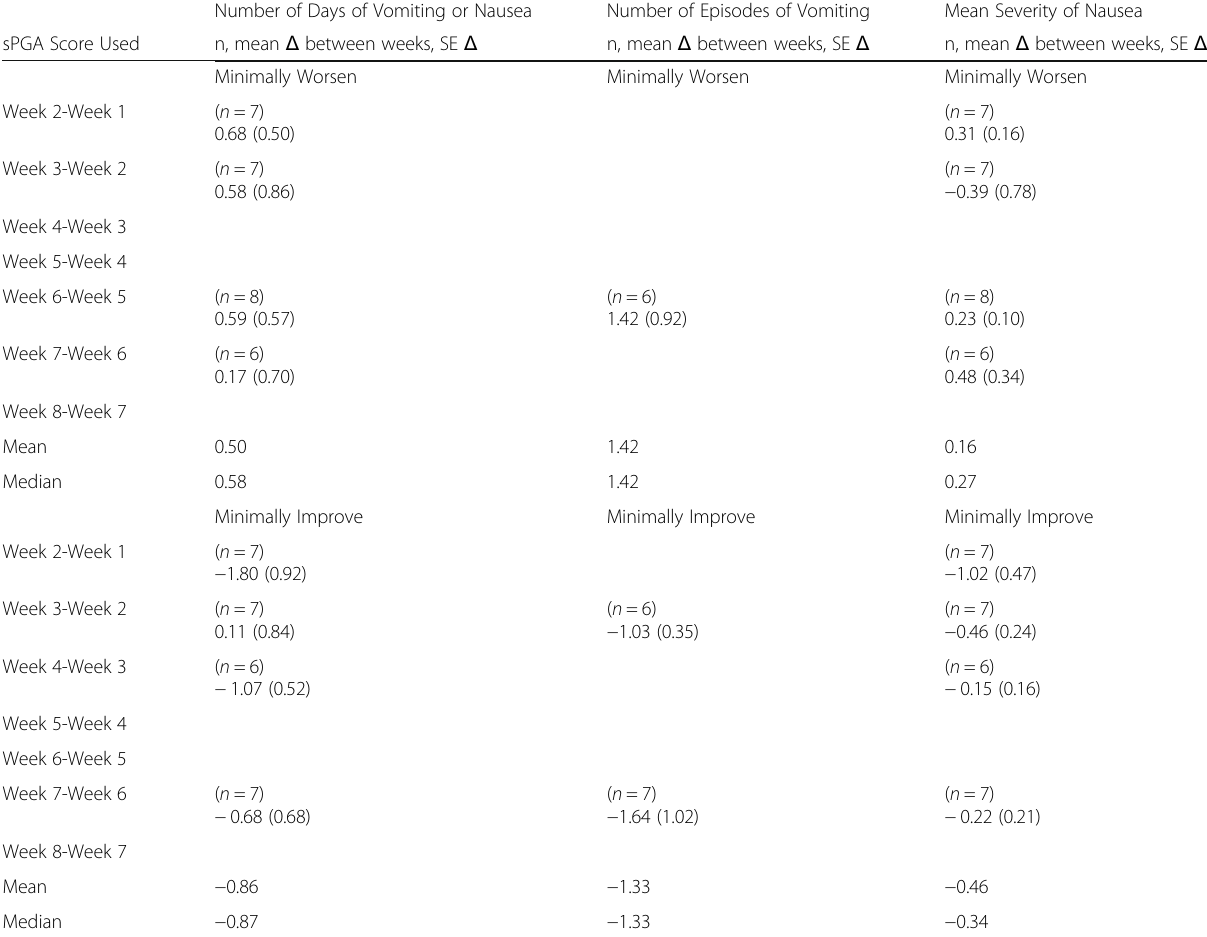
Table 9 Anchor-based assessment of meaningful change for NVSA © scores with sPGA Number of Days of Vomiting or